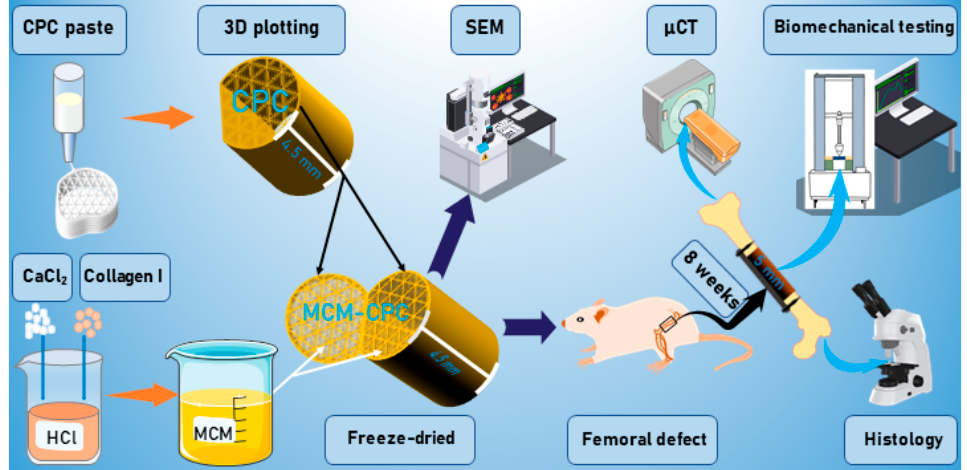
Figure 1. Scheme of the research and evaluation methods of this study (MCM: mineralized collagen matrix scaffold; CPC: calcium phosphate cement scaffold; MCM-CPC: hybrid scaffold consisting of 3D plotted calcium phosphate cement scaffold filled with mineralized collagen matrix; SEM: scanning electron microscopy; µCT: micro-computed tomography).